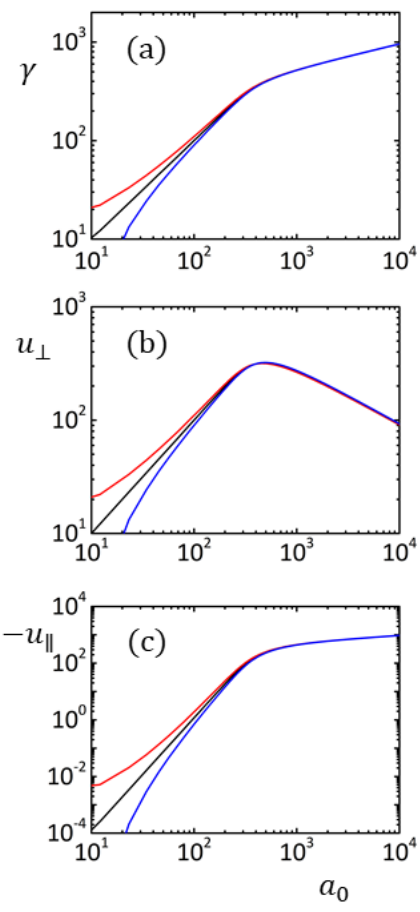
Figure 1. Dependencies of ( a ) the Lorentz factor γ , ( b ) the perpendicular component of the four-velocity u ⊥ , and ( c ) the parallel component of the four-velocity − u (cid:107) on the electric field intensity a 0 . In each figure, red, black, and blue lines correspond to the cases of b 0 = − 10, 0, and 10, respectively. Here, the frequency of the rotating electric field is ω = 2 π c × 10 6 , corresponding to ε (cid:39) 1.18 × 10 − 8 . All variables are dimensionless with normalization given in the